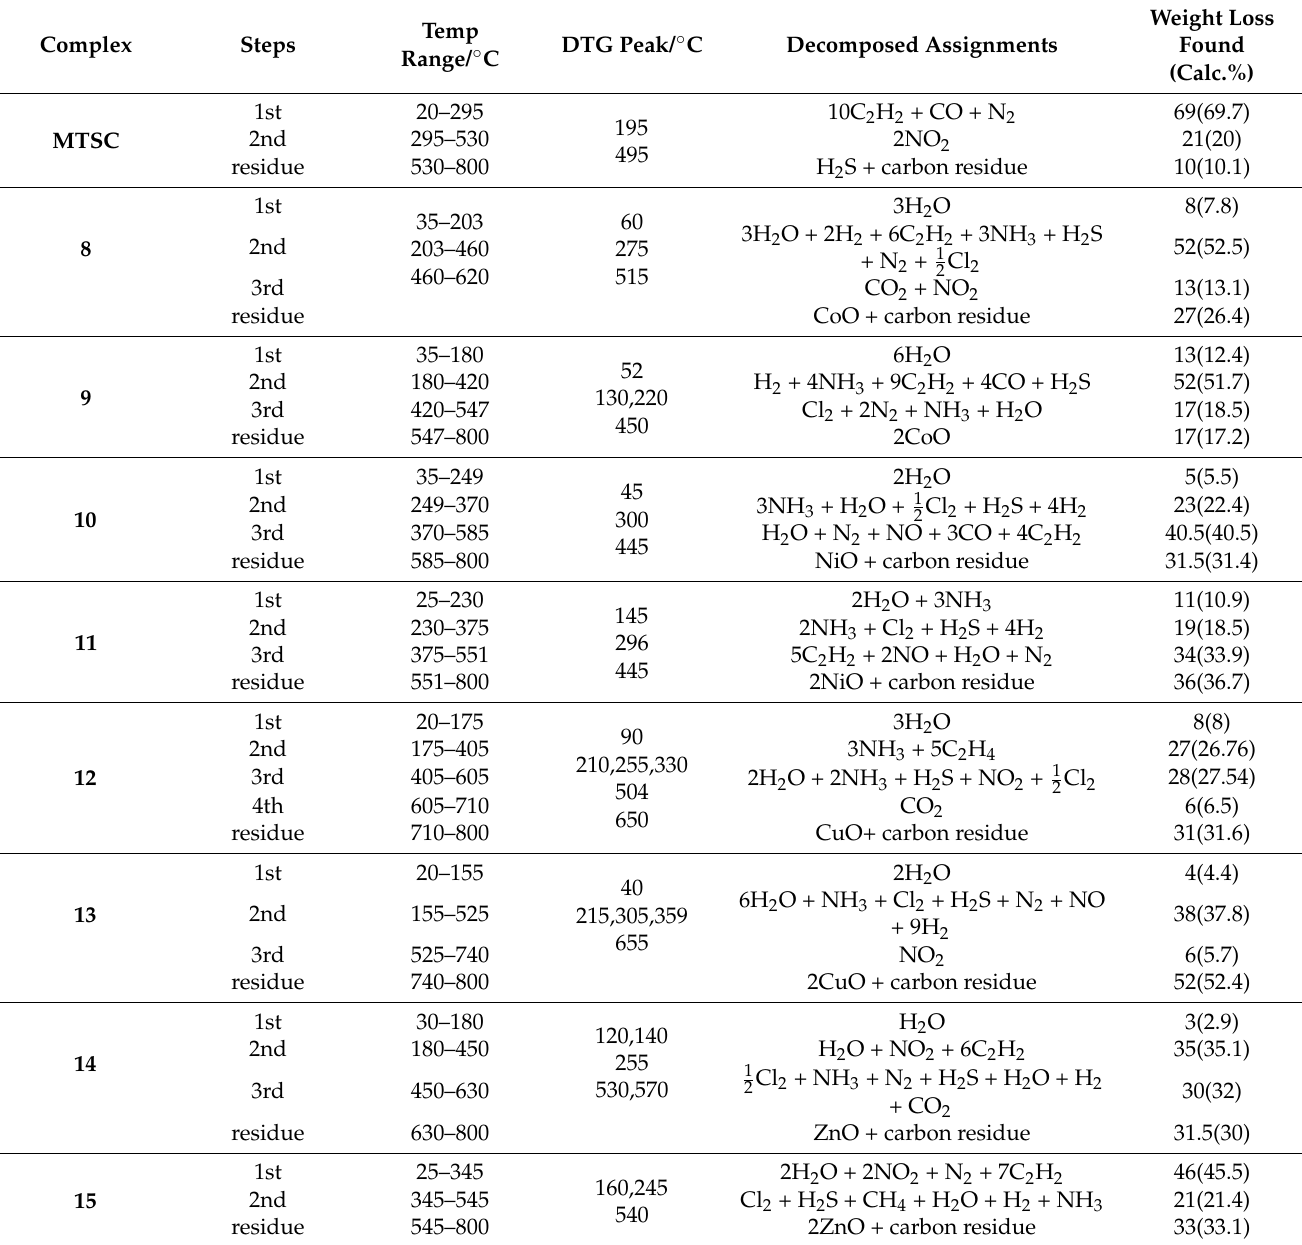
Table 3. Thermogravimetric analysis data of MTSC and its metal